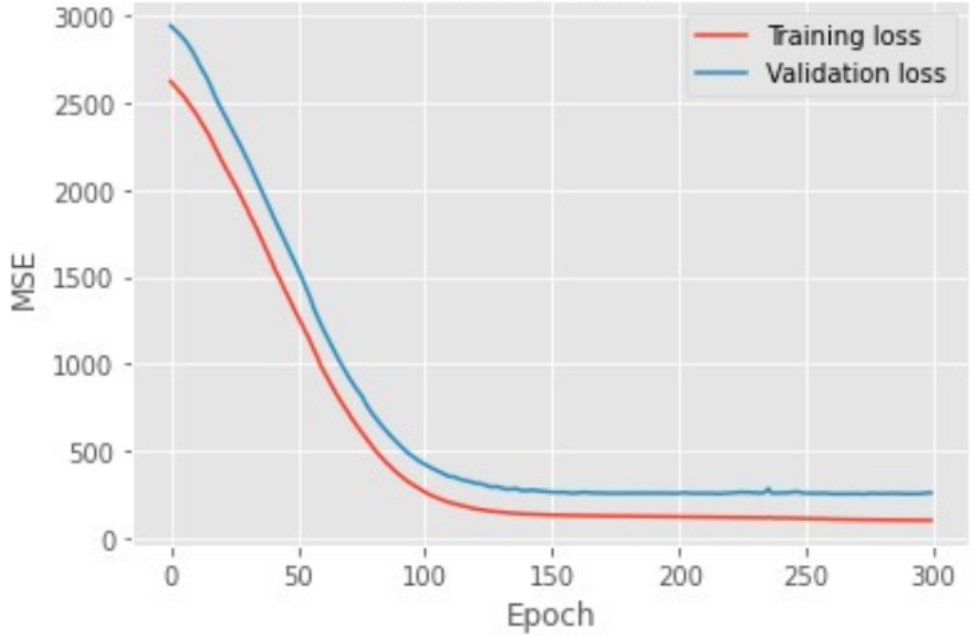
Figure 2. Training and validation loss of the long short-term memory model. MSE: mean squared error.